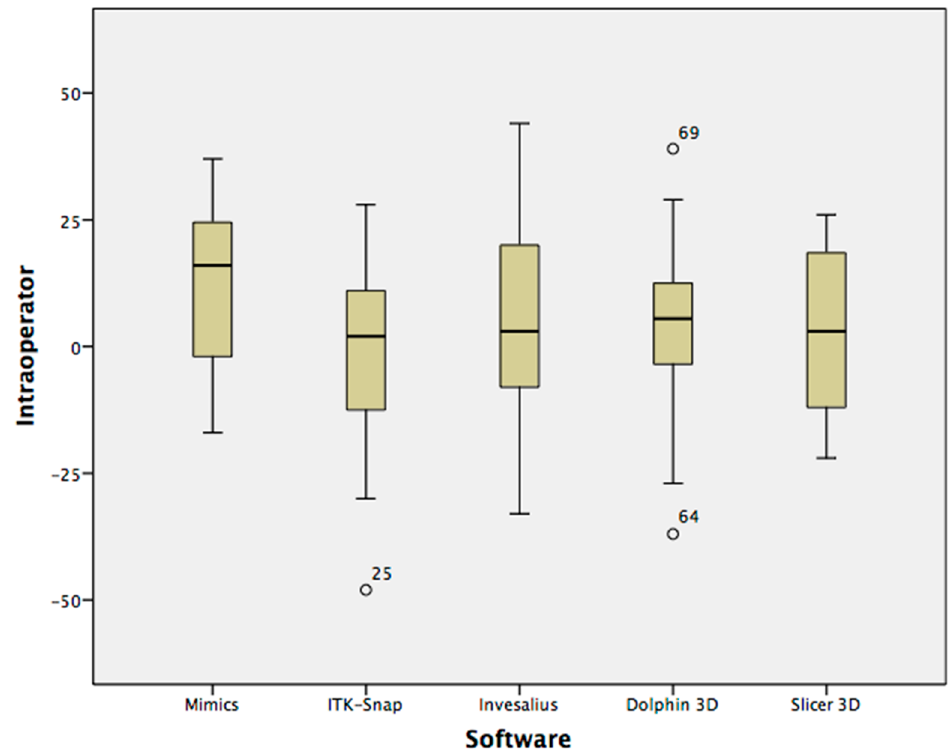
Figure 4. Box-Whisker plots of volumetric differences between first and second intra-operator readings.